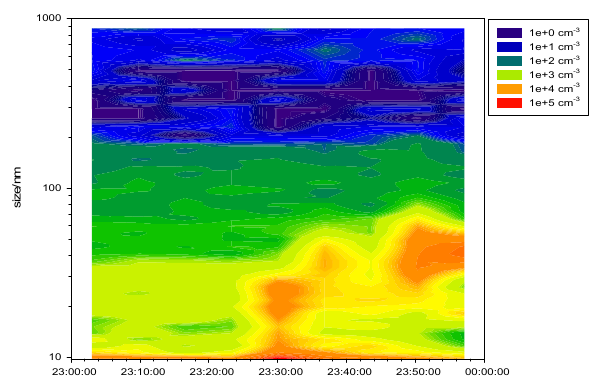
Fig. 10. Particle number size distribution (cm -3 ), showing particle growth on 13 February 2009, probably from new particles formed as the ship broke through the sea ice of the Weddell Sea.